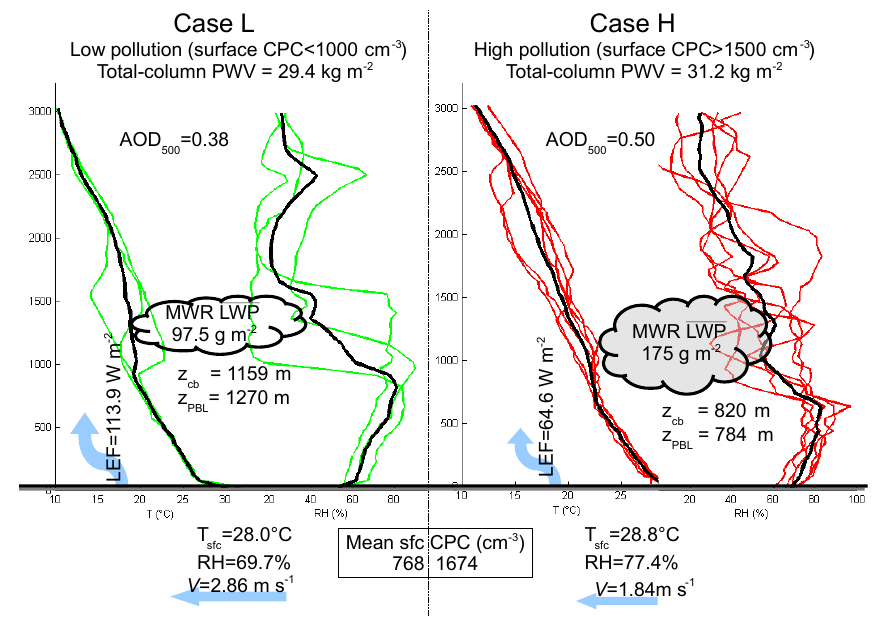
Figure 7. Characteristics of Case L vs. Case H conditions. By definition Case H has higher surface aerosol concentration; as expected, this is also true for AERONET-measured column AOD. Case H also sees higher humidity (RH), lower surface vapor fluxes (LEF), slightly higher average surface temperatures ( T sfc ), and lower wind speed (v) and, as shown by Fig. 6, has greater average cloud LWP. The lidar retrievals of cloud base and boundary layer height and the calculated LCL height are systematically lower for more polluted conditions.